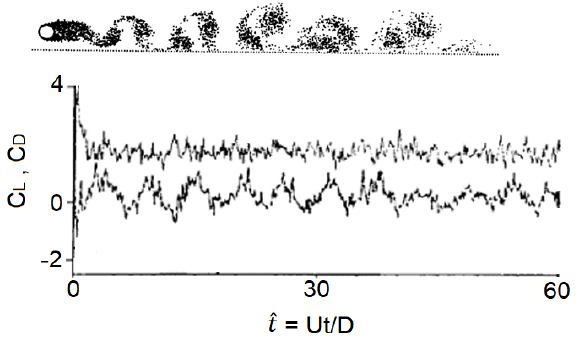
Figure 13. The flow pattern and force coefficients for G/D = 1 and Re = 500.